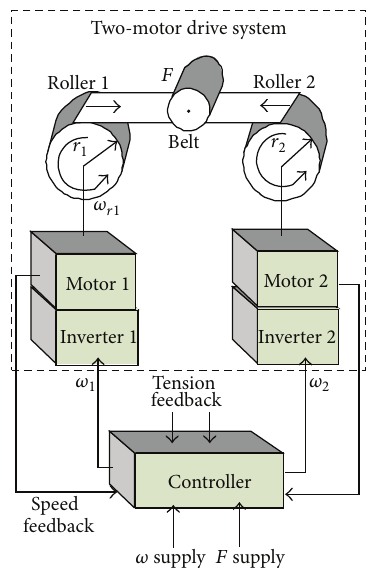
Figure 1: Physical model diagram of two-motor drive